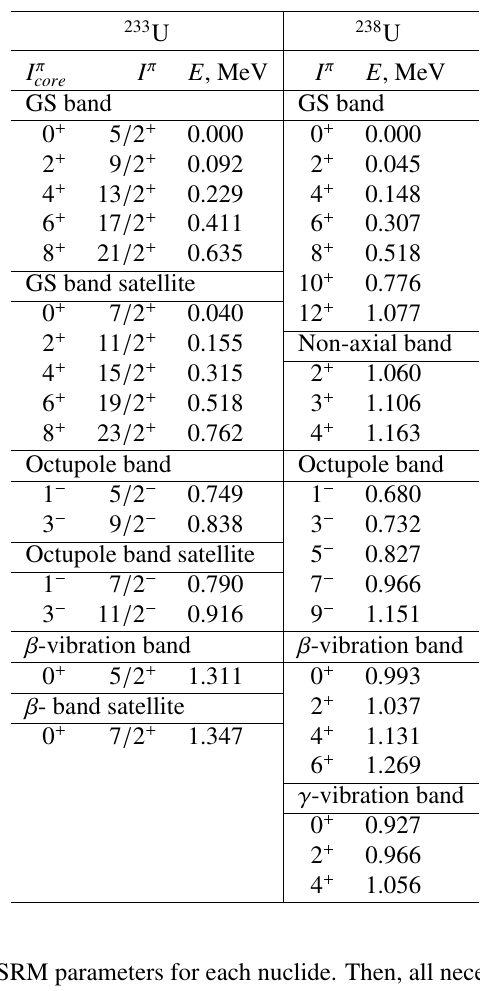
Table 1. Coupling scheme for 233 U and 238 U.